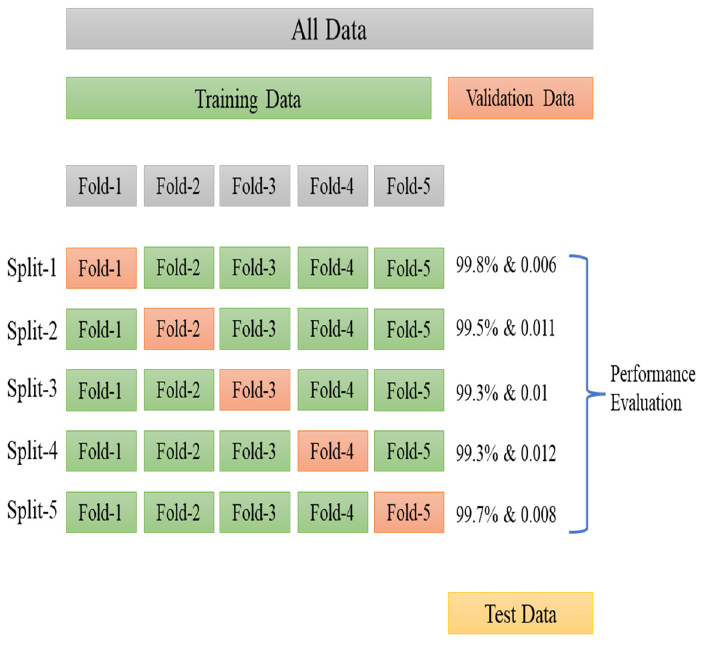
Figure 18. Five-fold cross-validation technique.